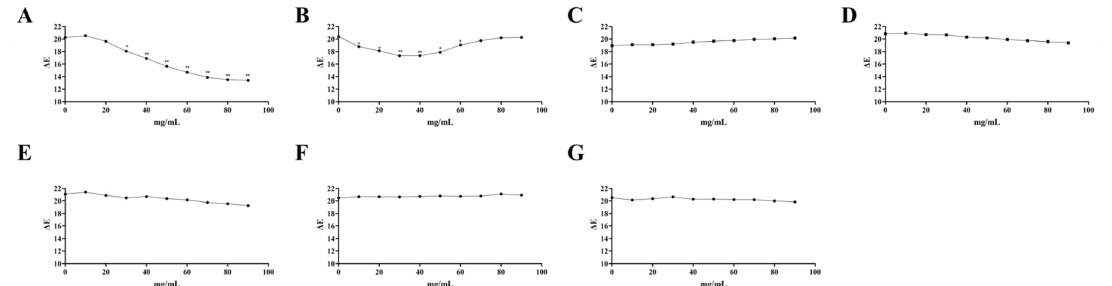
Figure A5. The effect of concentration of compounds on colour differences in anthocyanin solution.